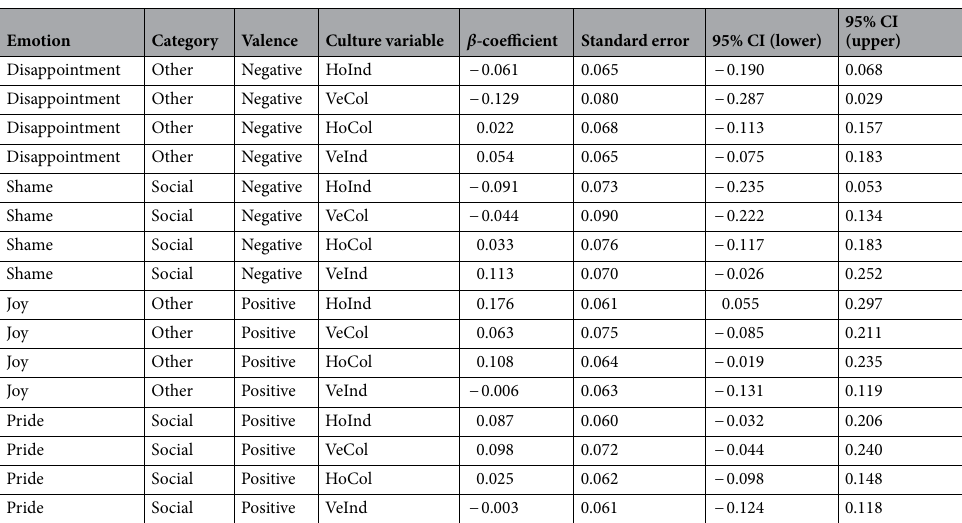
Table 2. The results of the analyses based on the aggregated data from studies 1 and 2. HoCol horizontal- collectivism, HoInd horizontal-individualism, VeCol vertical-collectivism, VeInd vertical-individualism.